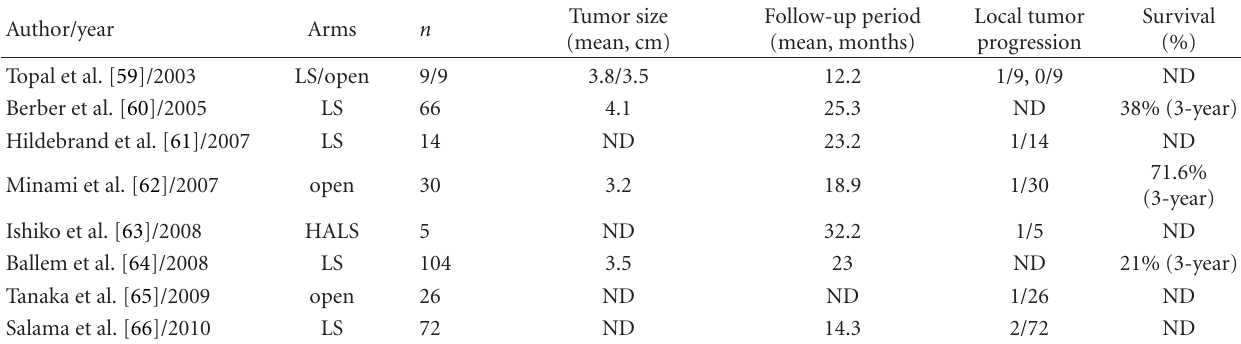
Table 4: Laparoscopic/open RFA for liver malignancies: local tumor progressions and